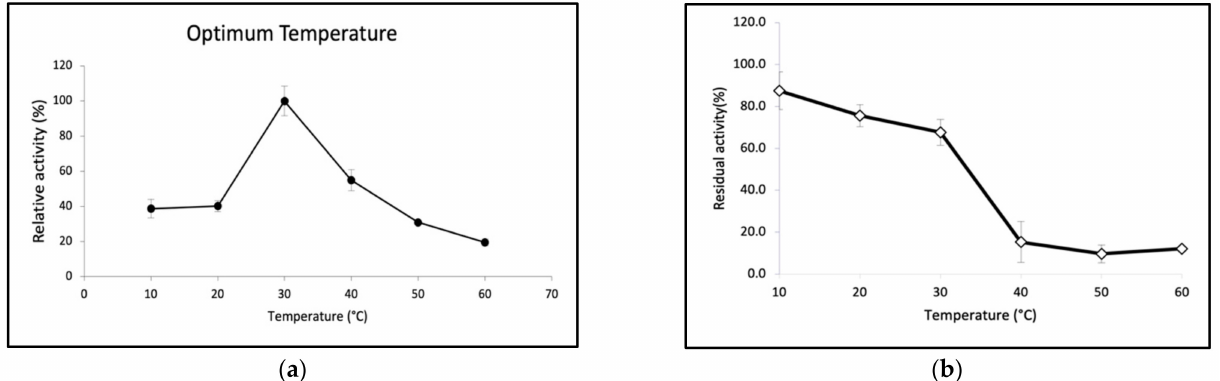
Figure 4. Effect of temperature on enzyme ( a ) activity and ( b ) stability of purified Ga PIP. The optimal temperature was determined by measuring the enzymatic activity and stability at different temperatures ranging from 0 to 60 ◦ C. The error bars represent the standard deviation ( n = 3).